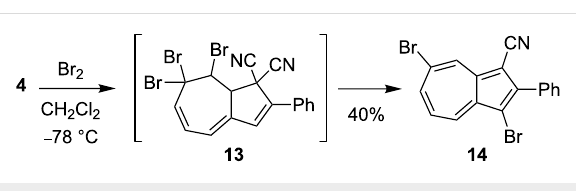
Scheme 6: Synthesis of a